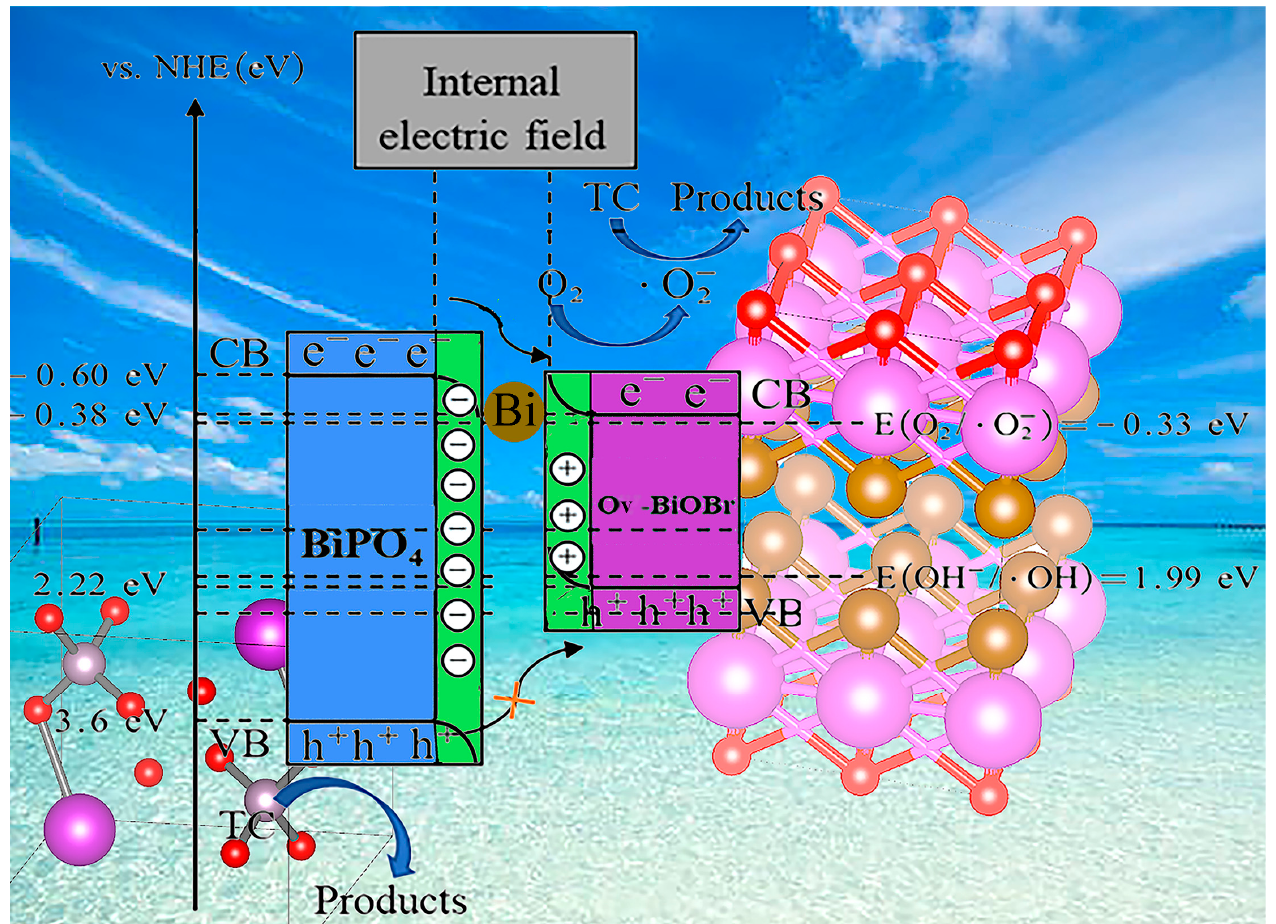
Figure 12. Photocatalytic mechanism of BiPO 4 /Ov-BiOBr high-low junction.